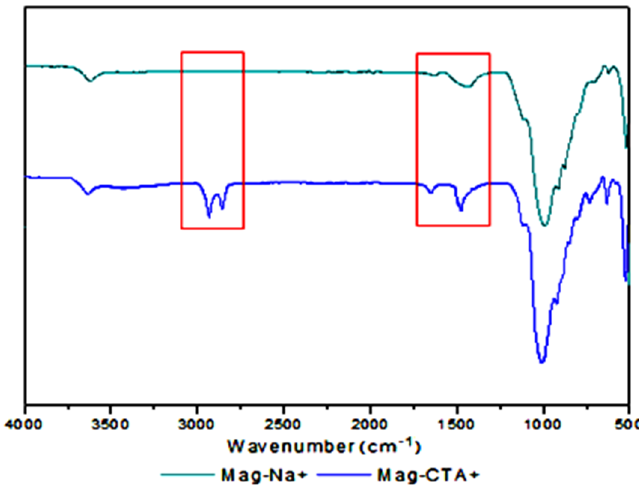
Figure 1. FT-IR spectra of Mag-Na + and Mag-CTA + .